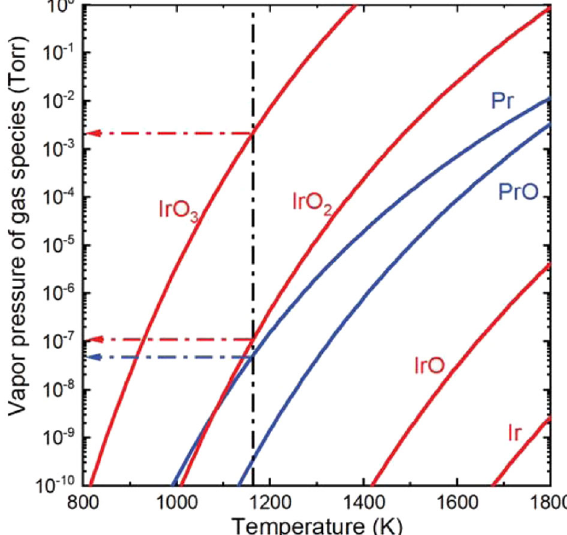
Fig. 2 Partial pressures of gas species in the Ir-O 2 and the Pr-O 2 binary systems. In thermodynamic calculations, the ratios of the components of Ir : O 2 and Pr : O 2 were fi xed at 1 : 1 and 2 : 1.5, to represent the compositions of IrO 2 and Pr 2 O 3 , respectively. The vertical dot-dashed black line indicates the growth temperature (1163 K) and the dot-dashed horizontal lines refer to the partial pressure of IrO 3 (g), IrO 2 (g), and Pr(g) gas species, respectively. More information is shown in Supplementary Fig. the partial pressure of IrO 3 (g) is 2 × 10 − 3 Torr. With O 2 (g) in the O binary compounds, or Ir precursor) provided from the source materials, the dominant Ir fl ux to the substrate surface is gaseous IrO 3 (g). The partial pressure of IrO 3 (g) depends on the equilibrium of species in gas phase such as O 2 (g) and Ir(g), and is not an independent thermodynamic variable nor an independent experi- mental growth parameter. This high vapor pressure of IrO 3 (g) explains the common Ir de fi ciency of thin fi lms 24 .